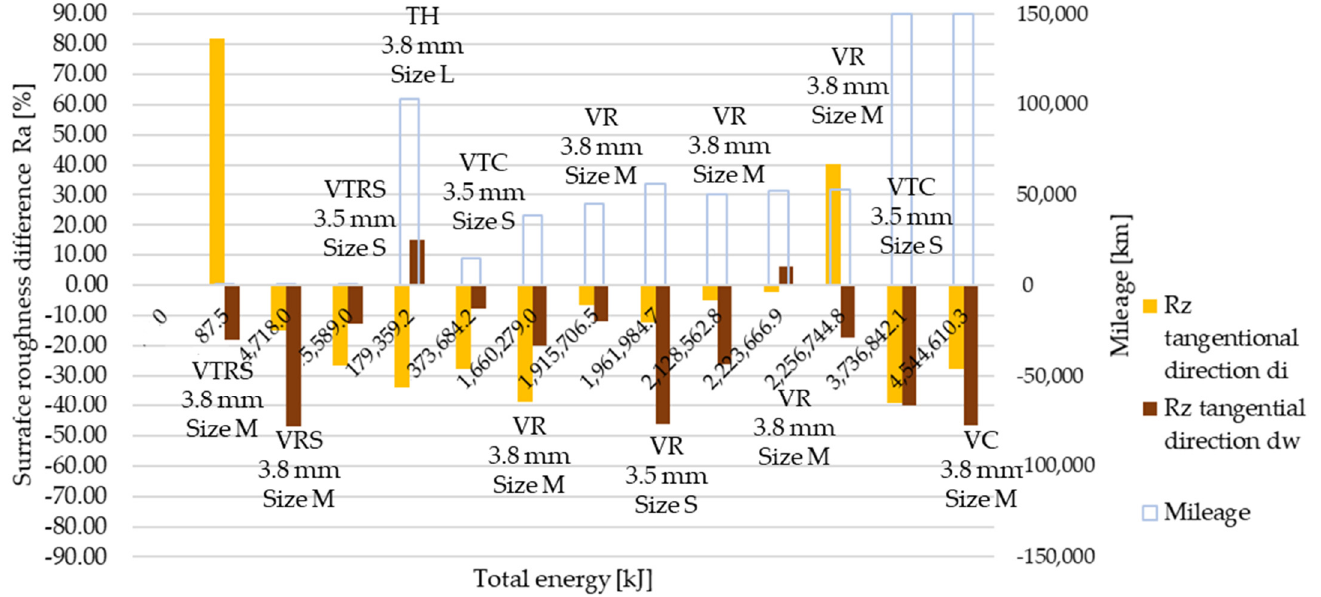
Figure 14. Deviation of Rz surface roughness values from initial conditions, radial direction.